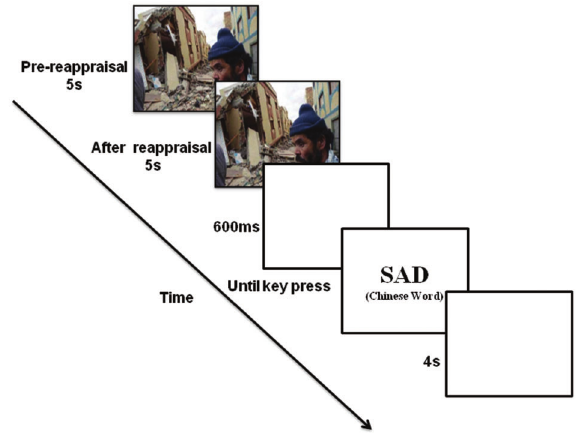
Figure 1. Reappraisal task procedure. Participants viewed the pictures for 5 s, and then they reappraised them. After a 5-s regulation period and a short delay, a negative or neutral word appeared. Participants were asked to press response buttons to indicate whether the word was negative or neutral. Reaction time, P200, and P300 were measured in response to the negative and neutral